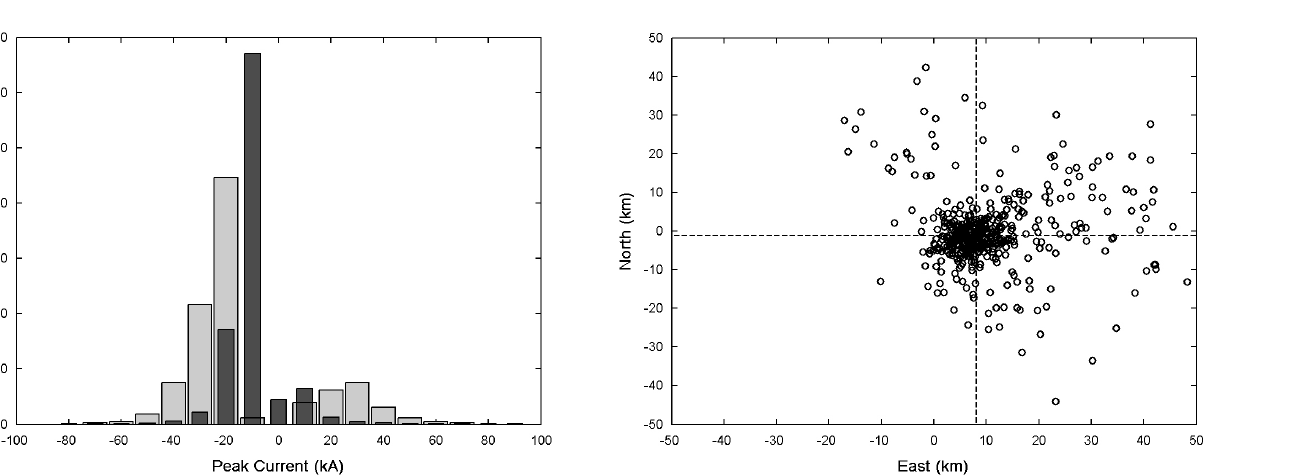
Fig. 5. Distribution of return stroke peak currents determined by the Kattron lightning network. The dark bars show the distribution for all lightning events detected over 23–24 January 2002, while the lighter events show the current distribution for those events which were also detected by the experimental WWLL network.